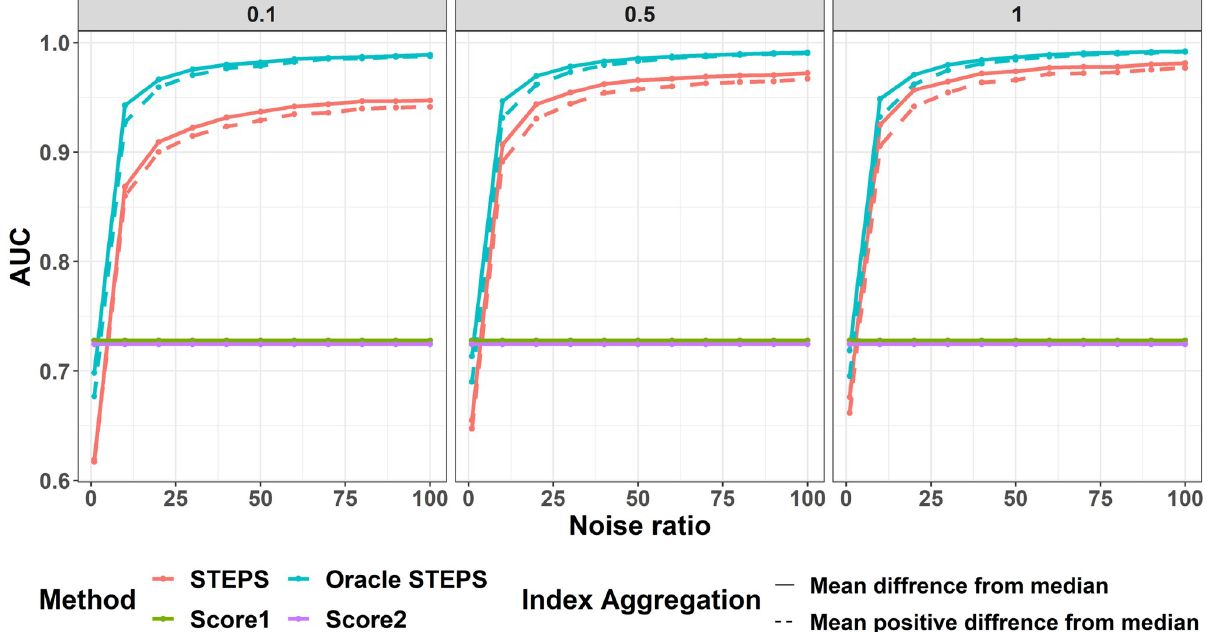
Fig 6. AUC values. X-axis is the noise ratio. Y-axis average AUC values. Color represents the different models and line type distinguishes between aggregation methods for the STEPS scores. Columns are different λ W rates.